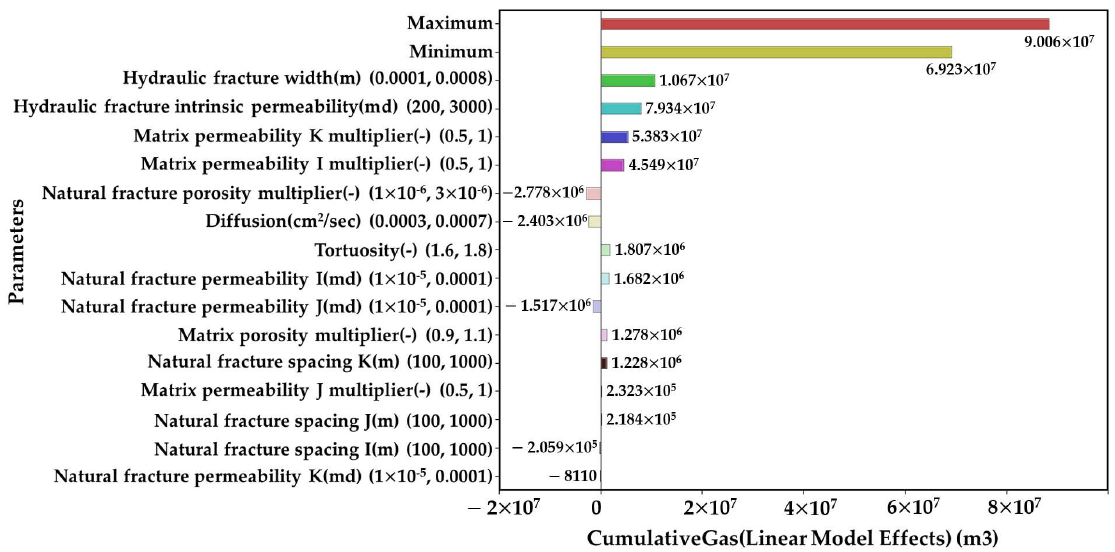
Figure 11. Tornado plot of linear effect estimates for cumulative gas production (fixed SRV) Horn River case.